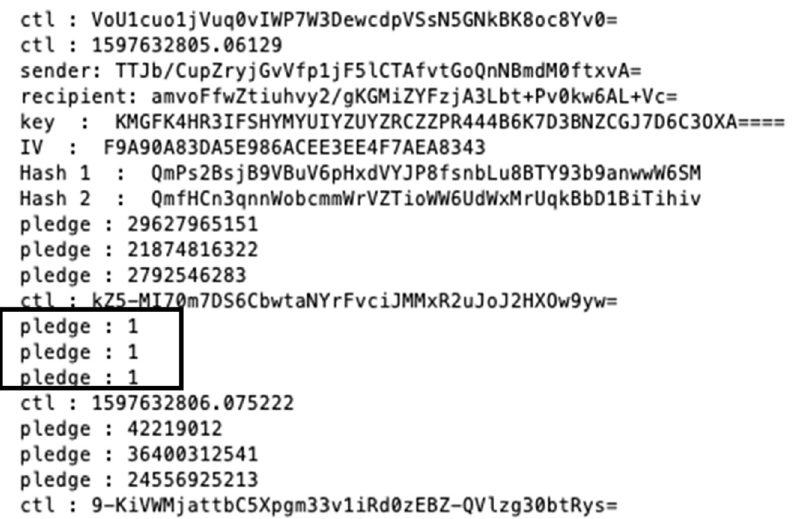
Figure 9. The transaction log related with consensus.